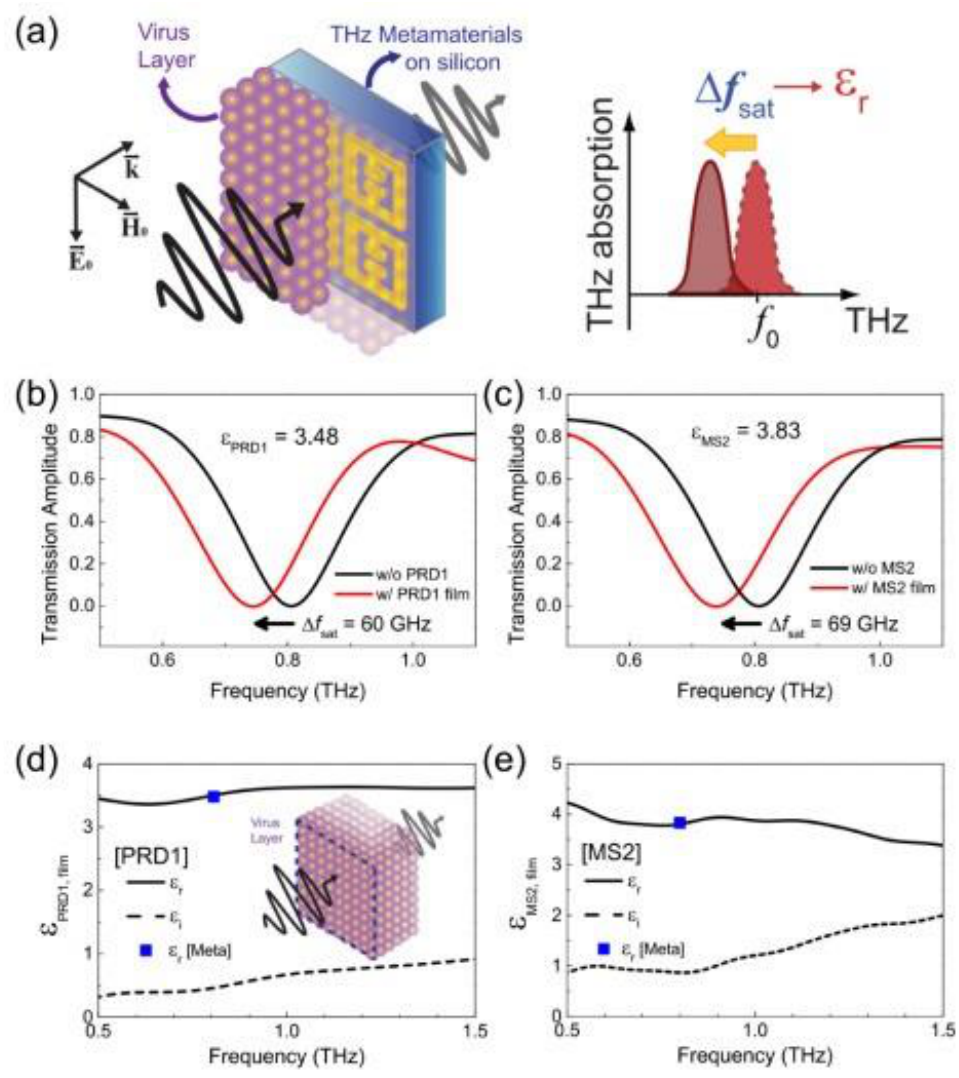
Figure 5. ( a ) The layout of dielectric constant measurements using a THz metamaterial sensor. THz transmission vs. frequency, with and without the deposition of the layer of ( b ) PRD1 and ( c ) MS2 viruses. The dielectric constants of 3.48 and 3.83 are estimated from the resonant frequency shift, for PRD1 and MS2, respectively. Frequency-dependent complex dielectric constants vs. frequency are reported for ( d ) PRD1 and ( e ) MS2 layers. The thicknesses of the PRD1 and MS2 layers were 300 µm and 150 µm, respectively. Reprinted with permission from [82] © The Optical Society.